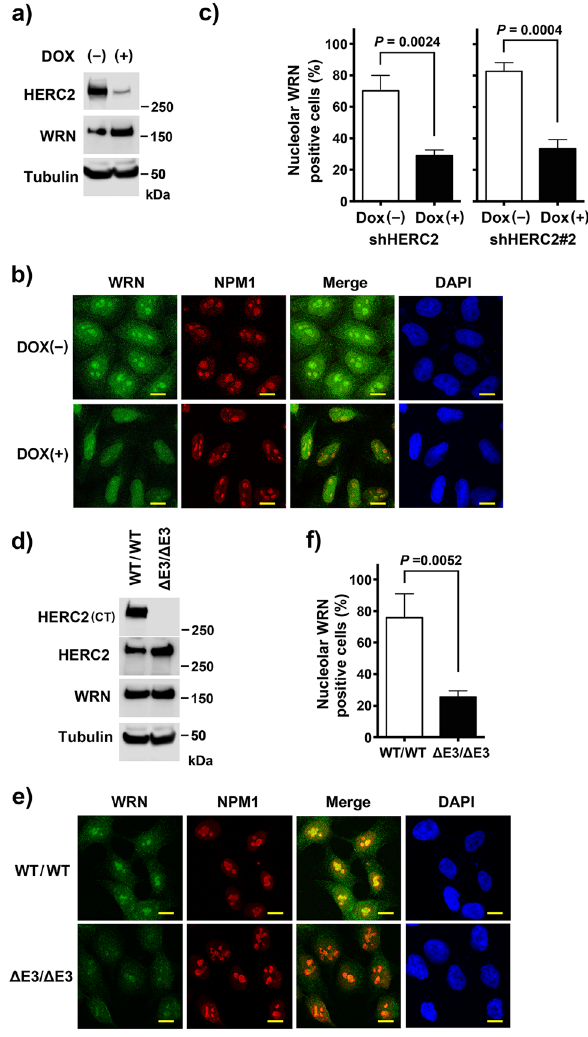
Figure 2. Nucleolar localization of WRN requires HERC2 and its E3 domain. (a,b) HeLa-shHERC2 cells, with or without Dox-mediated induction, were subjected to immunoblotting (a) or immunostain (b) with the indicated antibodies. The nuclei were counter stained with DAPI. Scale bar, 10 μm. (c) Quantifications of the nucleolar WRN positive cell from (b) (left panel), and those from HeLa cells with a different shRNA (shHERC2#2, right panel, see also Supplementary Figure S1) are shown. Error bars, S.D. of three independent experiments, each based on more than 100 cells. Statistical significances was calculated using the Student’s t- test. (d,e) Wild-type or HERC2 ΔE3/ΔE3 HCT116 cells were subjected to immunoblotting (d) or immunostain (e) with the indicated antibodies. Scale bar, 10 μm. (f) Quantification of the nucleolar WRN positive cell. Error bars, S.D. of three independent experiments, each based on more than 100 cells. Statistical significances was calculated using the Student’s t- test. Full-length blots/gels are presented in Supplementary Figure